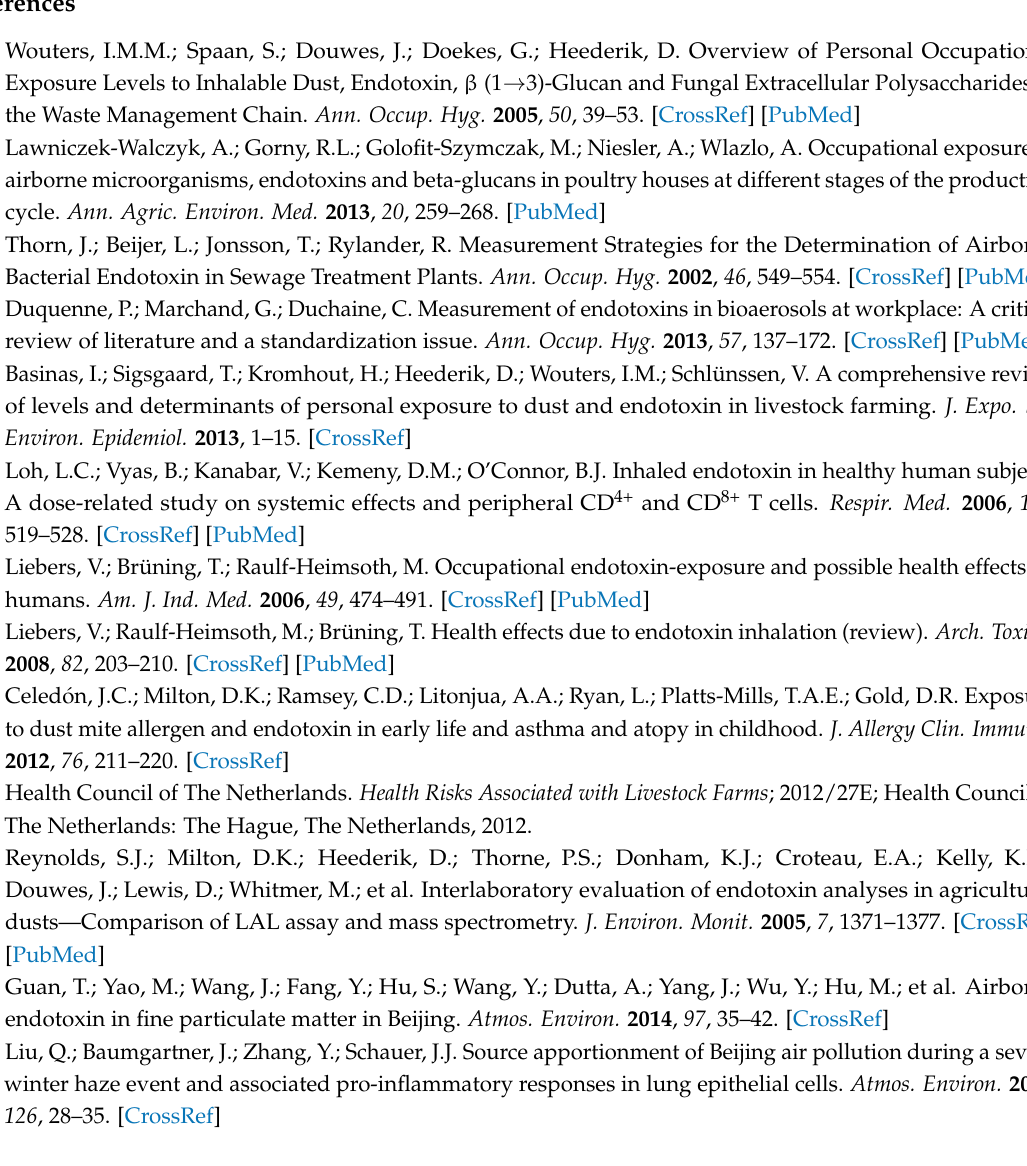
Table S1: Search terms; Table S2: Sources for particle size graph; Table S3: Sources for endotoxin concentration and distance